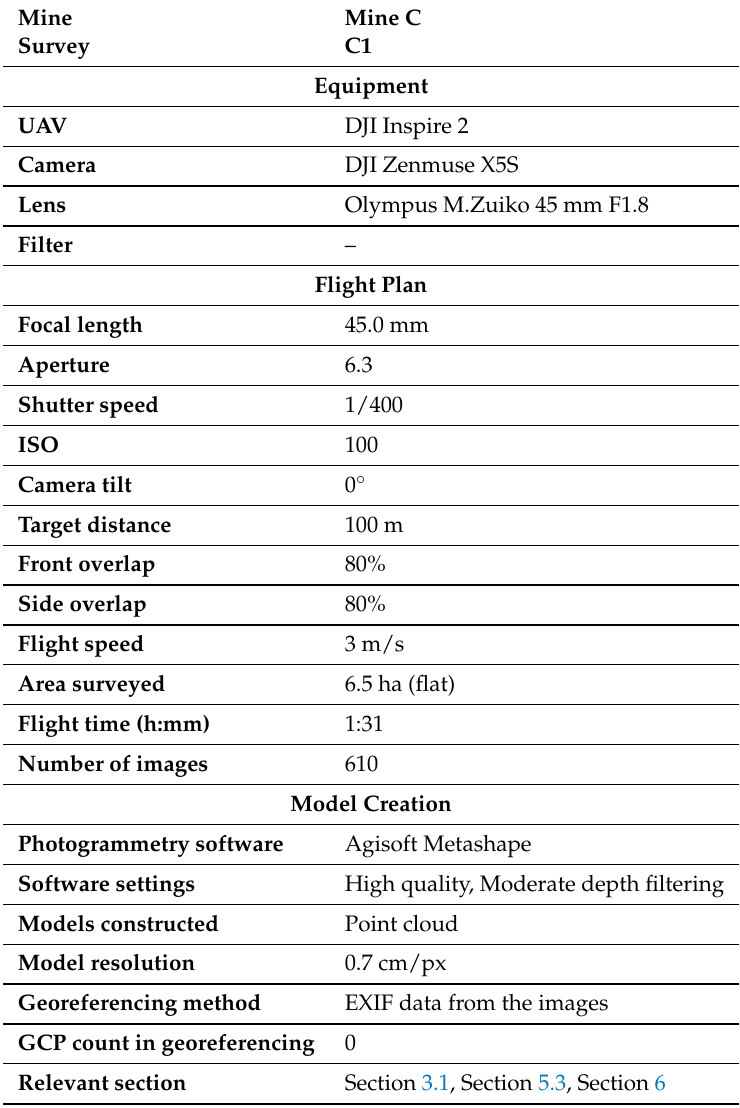
Table A3. Workflow for Mine